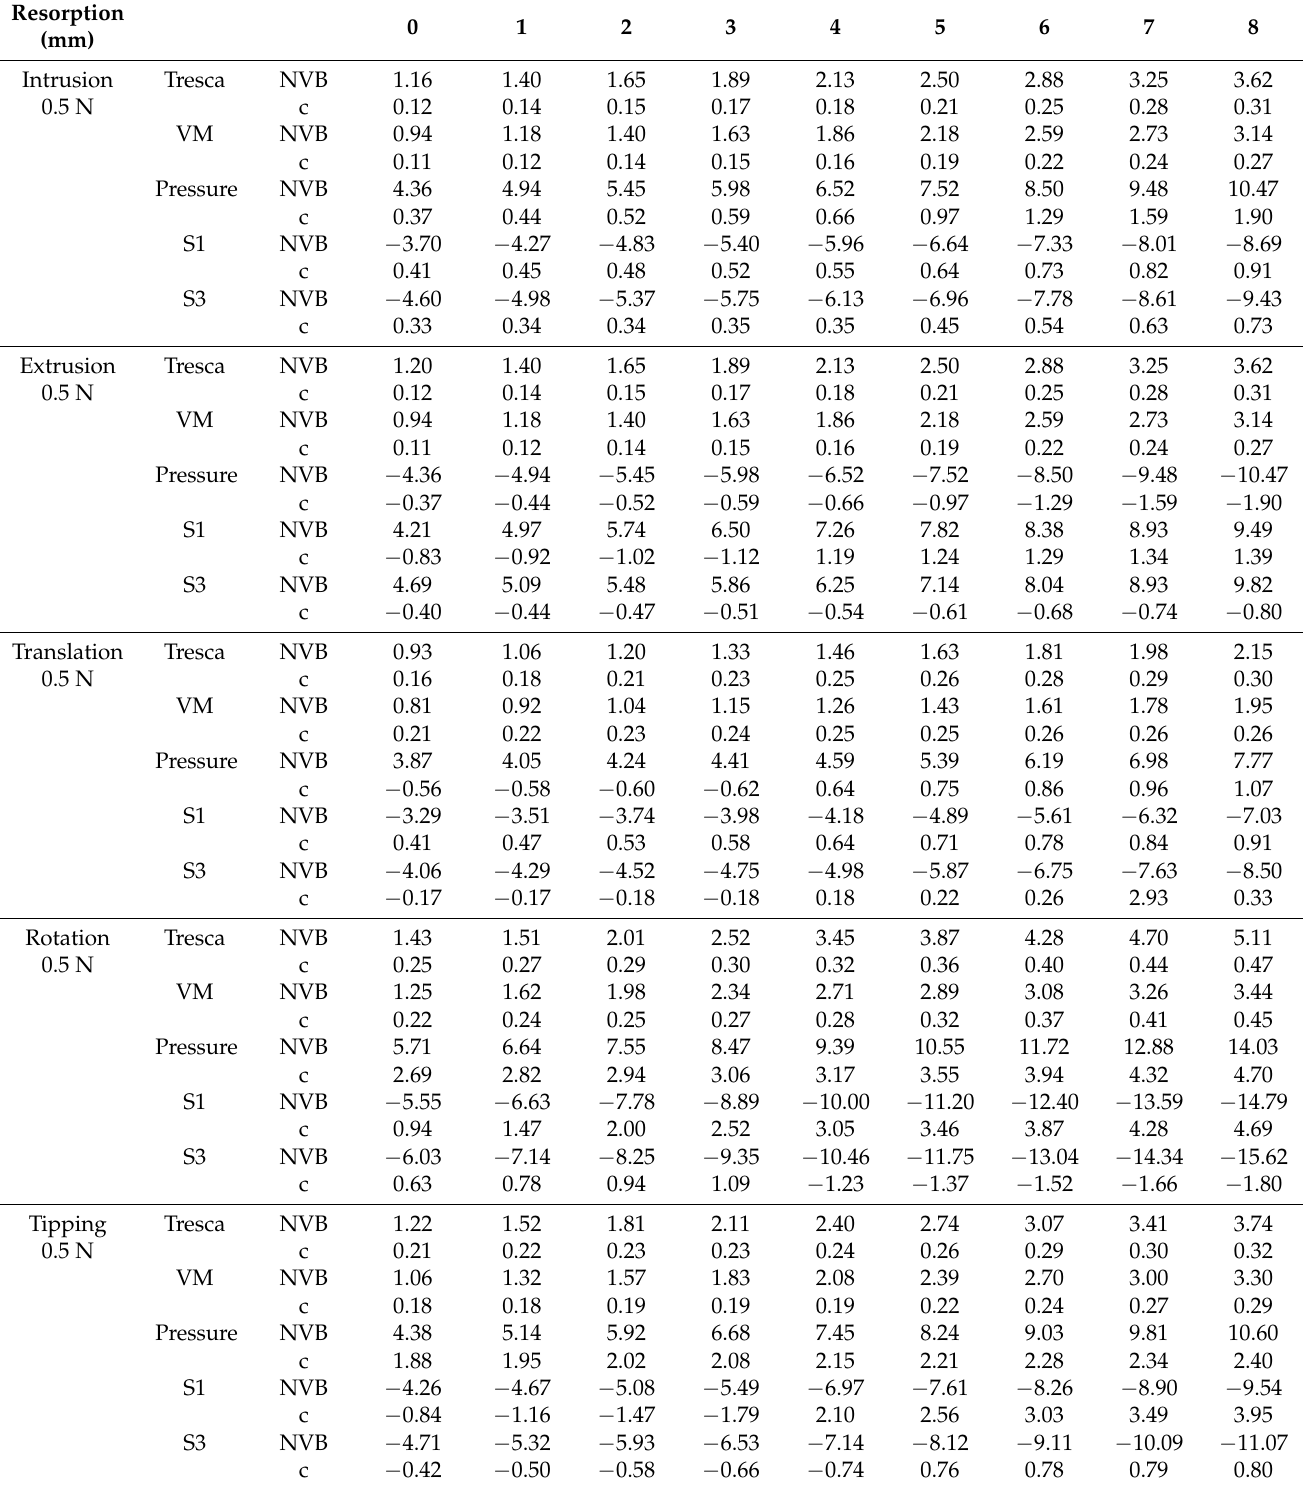
Table 2. Maximum stress average values (KPa) produced by orthodontic forces: NVB- apical neu- rovascular bundle; c-coronal